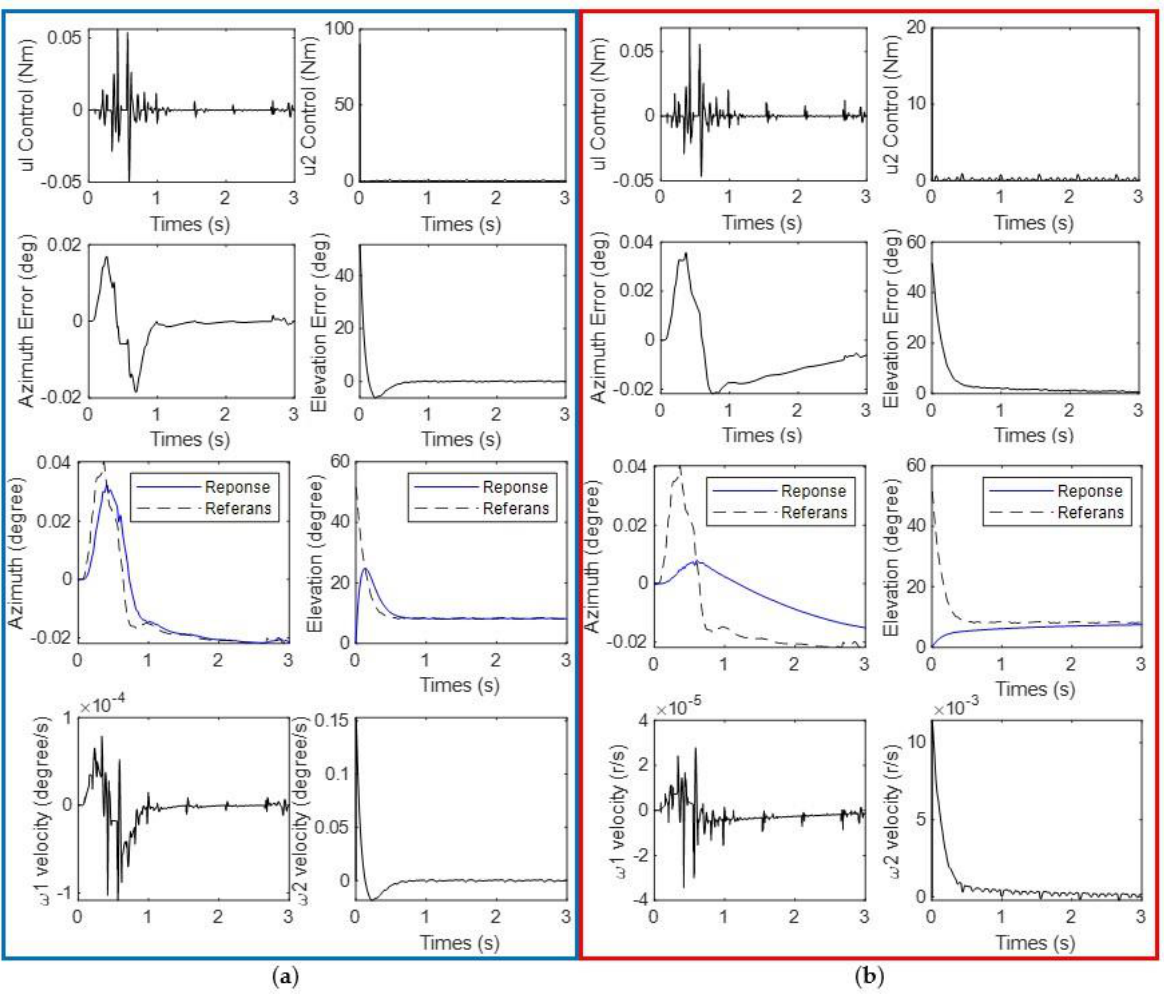
Figure 16. Control signals, error values, trajectory and velocity of Turret System elevation and azimuth motor with ( a ) SMC ( b ) PID controllers for Scenario 2.